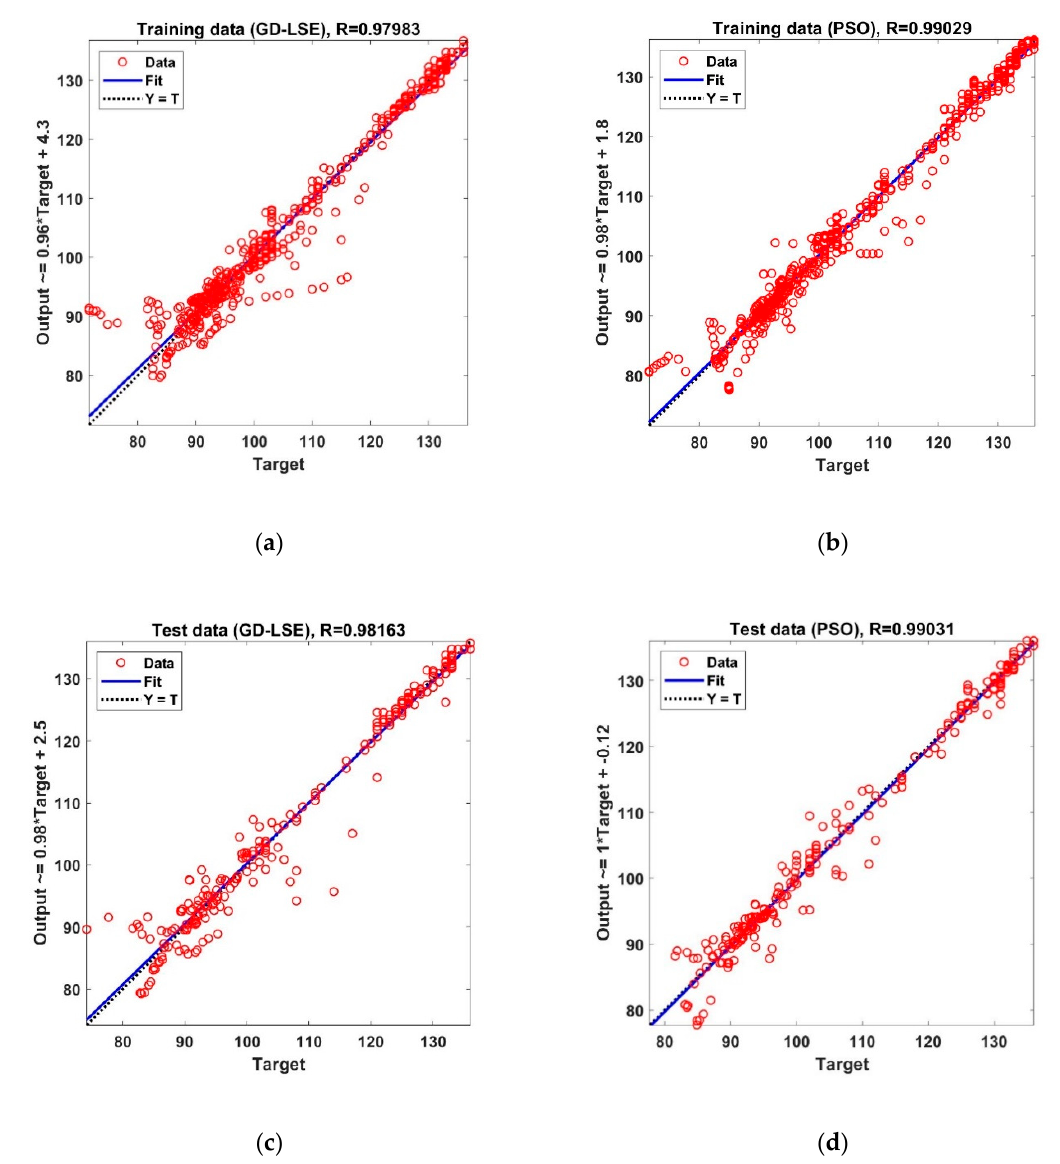
Figure 6. Comparison of regression plots between GD-LSE ANFIS and PSO ANFIS models for prediction of evaporator outlet temperature, T r,out , using the training and test data: ( a ) training data (GD-LSE); ( b ) training data (PSO); ( c ) test data (GD-LSE); and ( d ) test data (PSO).